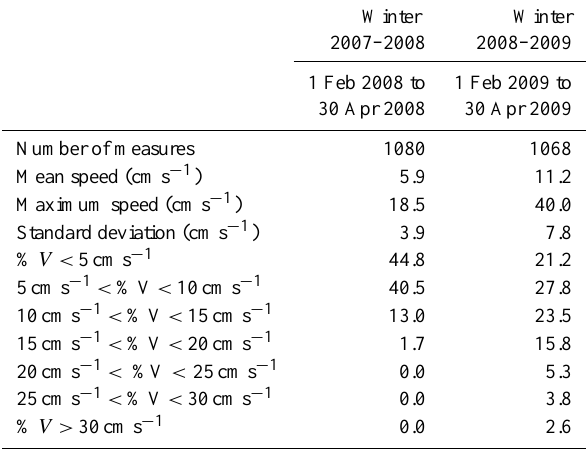
Table 4. Statistics of near bottom hourly current speed measured